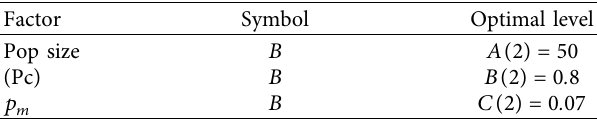
Table 4: Optimum levels of GA parameters in medium size instances.